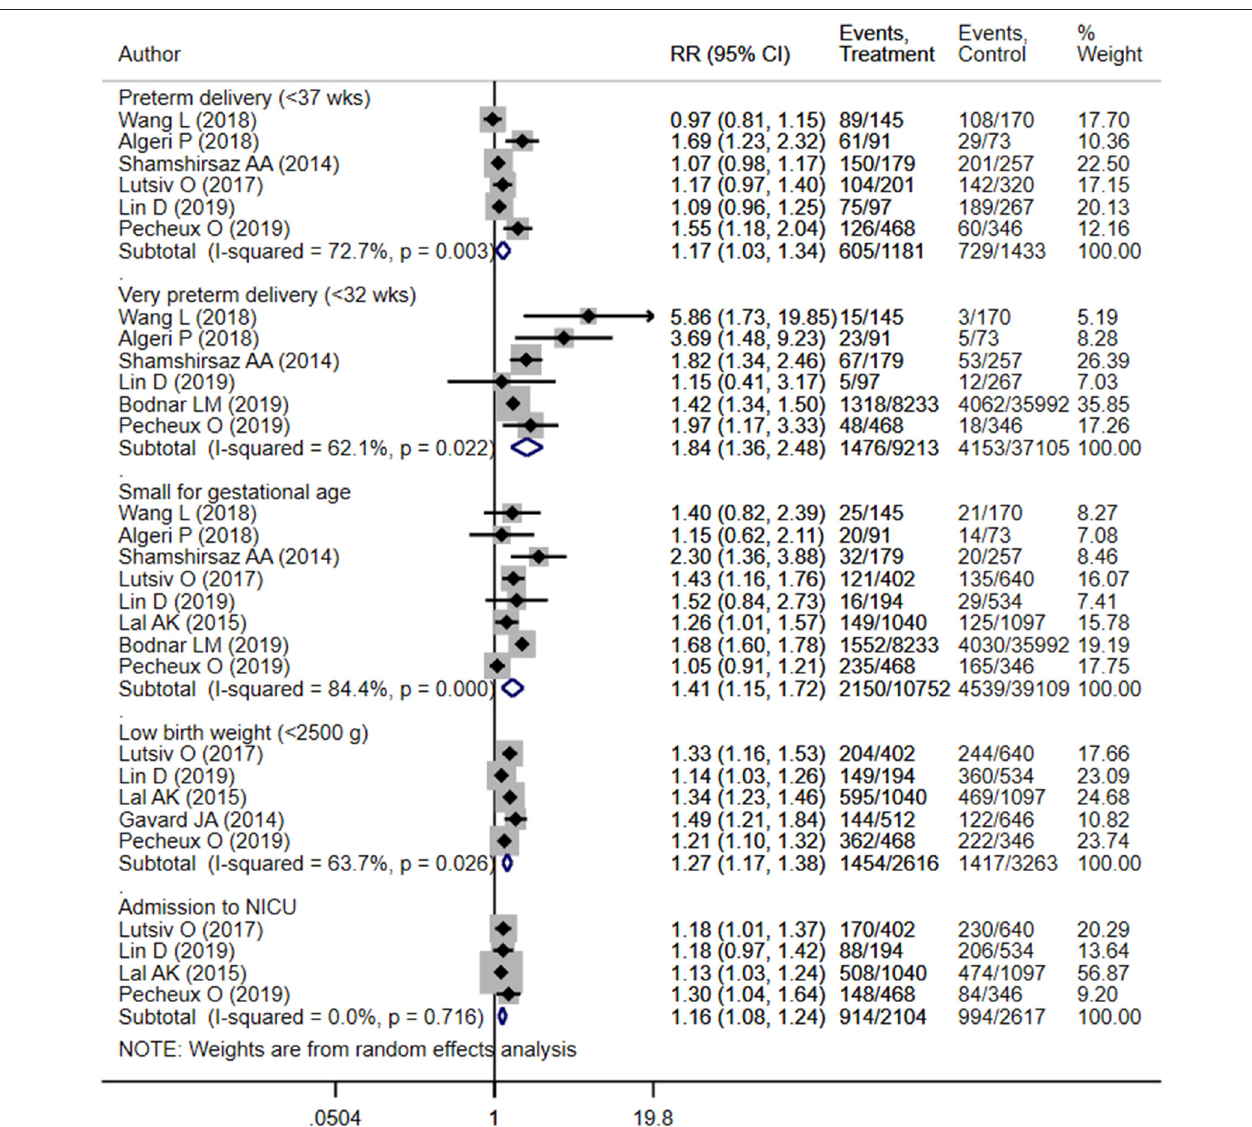
FIGURE 3 | Pooled analysis of inadequate or adequate pregnancy weight gain effects on neonatal health outcomes.